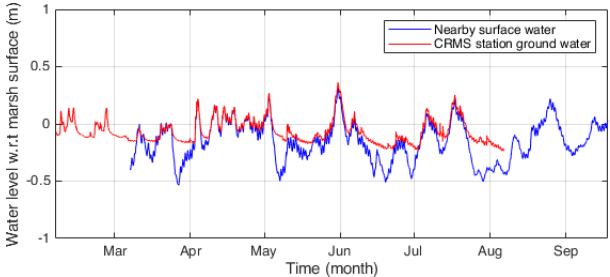
Figure 6. Ground water and surface water levels for CRMS site 114, located 37m from the marsh edge from February– September